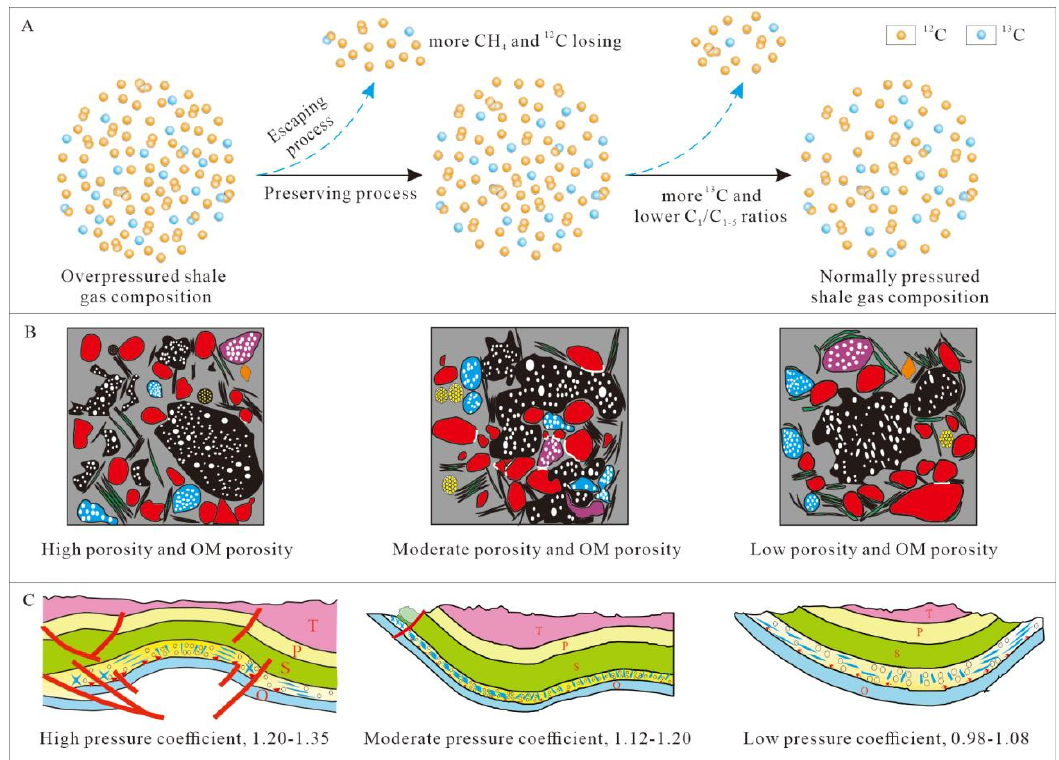
Figure 6. Schematic diagram of the variation in carbon isotope compositions ( A ) and pore distribu- tions ( B ) for shale gas systems during geologically long-term preservation and loss processes under different structural conditions with various pressure coefficients ( C ). Letters T, P, S, O represent Triassic, Permian, Silurian, and Ordovician stratas.